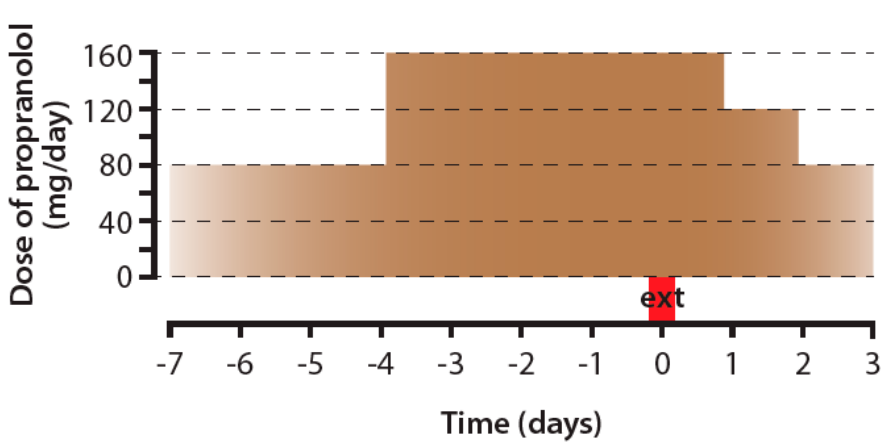
Figure 2. Dosage of propranolol used to prevent perioperative and postoperative metastases in a clinical study by Hiller, et al. [96]. At the beginning (day − 7), patients received 40 mg of propranolol twice a day; from day − 4, they received 80 mg twice a day, and after the operation, the dose was gradually reduced. ext—day of tumor tissue extirpation.